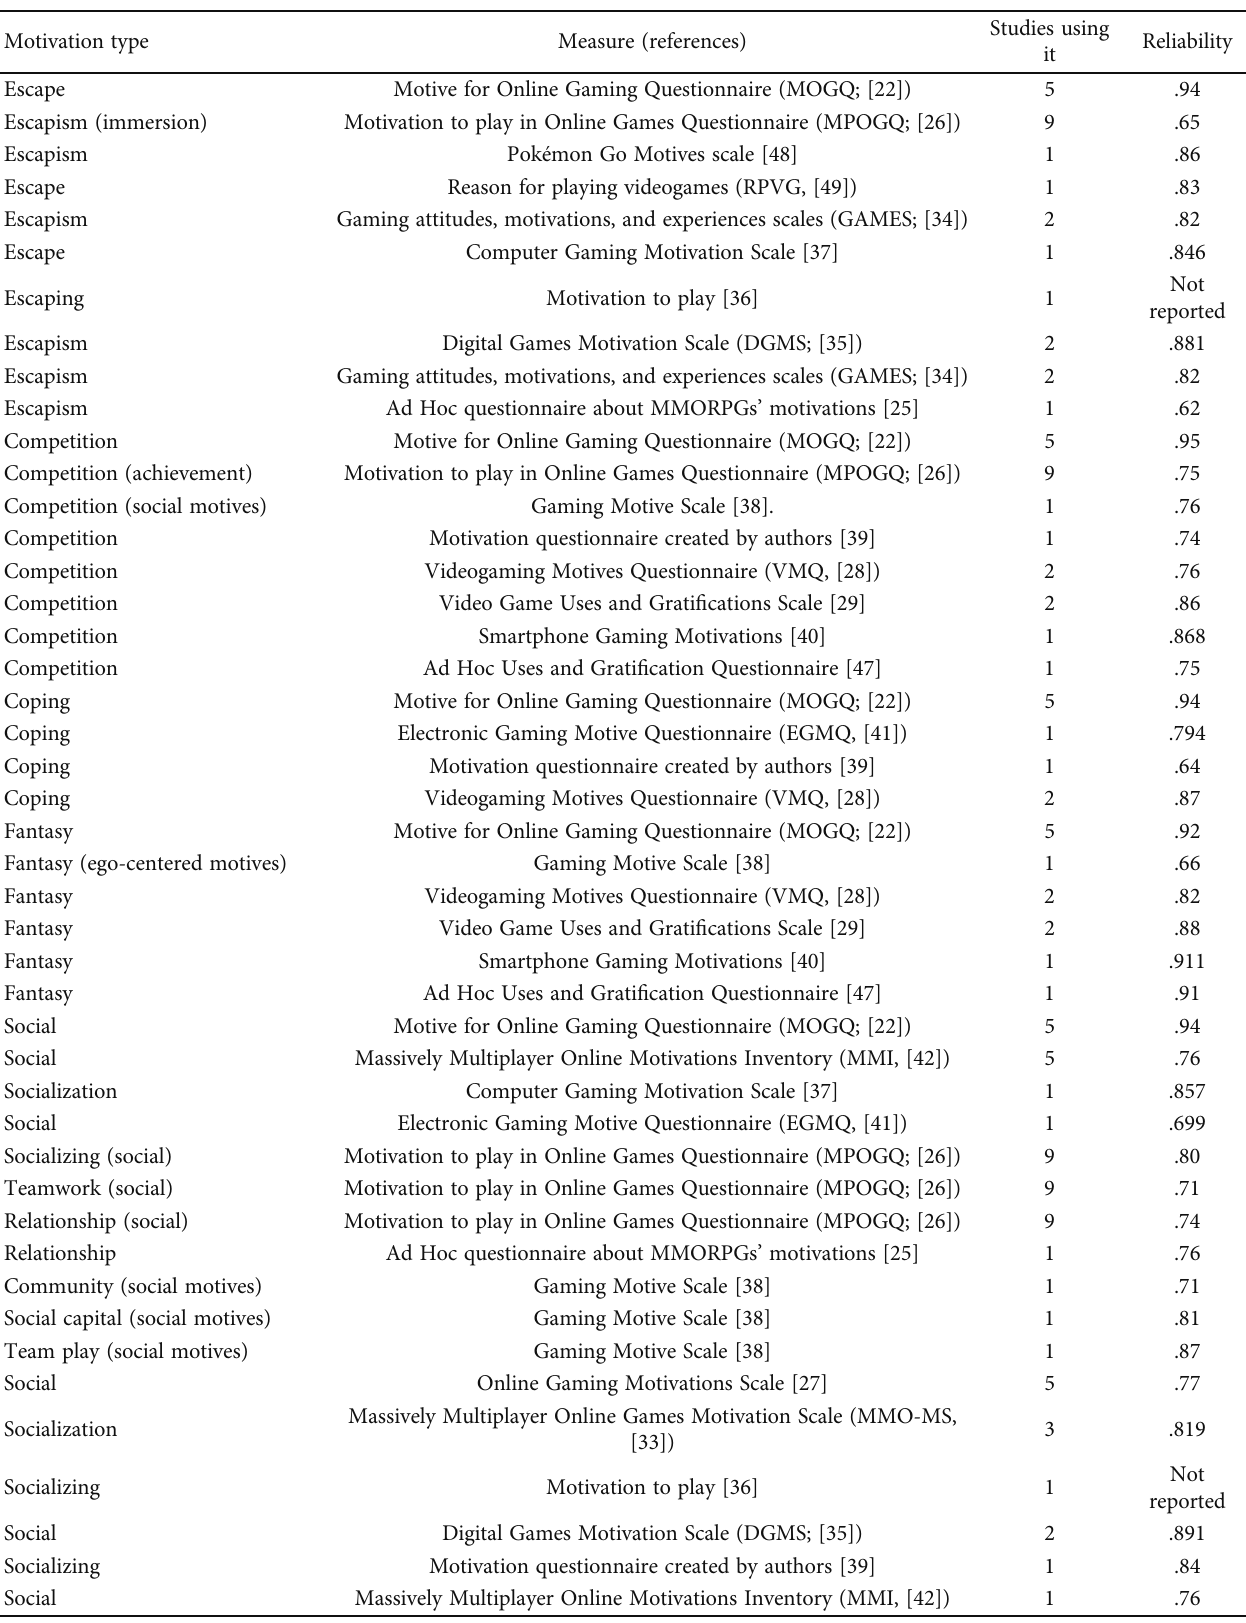
Table 1: Instruments used by the papers in this PRISMA systematic review with all the dimensions and their Cronbrach ’ s